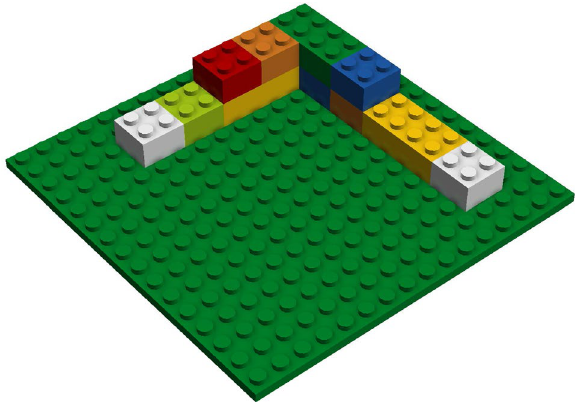
Figure 1. Duplo construction consisting of the first 12 parts of Funk’s standardized assembly task 8 .